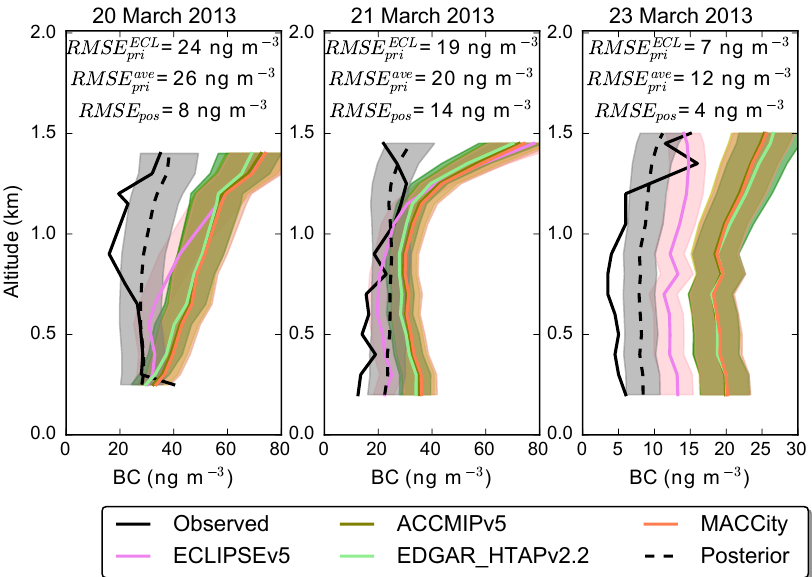
Figure 7. Comparison of prior (ECLIPSEv5, ACCMIPv5, EDGAR HTAPv2.2 and MACCity) and posterior simulated concentrations of BC with observations from the ACCACIA flight campaign near Zeppelin station, Ny-Ålesund, in 2013, adopted from Sinha et al. (2017). The variability of the prior concentrations (shaded area) was calculated as the standard deviation of BC concentrations from the 12 species with different scavenging coefficients as shown in Table 2. Uncertainties of the posterior concentrations are due to scavenging and use of four different a priori datasets (Sect. 3.4). RMSE values are computed for ECLIPSEv5 concentrations, all prior concentrations (average) and posterior simulated BC